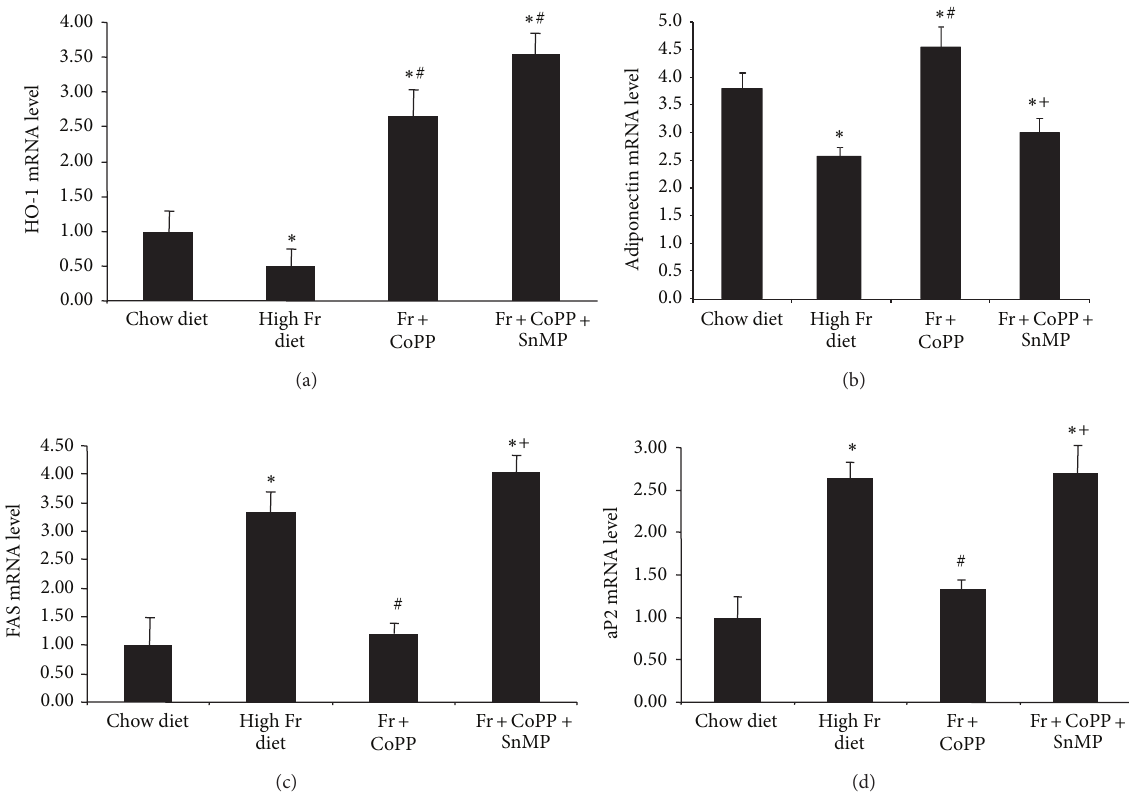
Figure 8: (a) Real-time PCR of HO-1, (b) adiponectin, (c) FAS, and (d) aP2 expression in chow diet, high fructose diet, and fructose diet treated with CoPP, in the presence or absence of SnMP. Values represent means ± SEM of five independent treatments. ∗ 𝑃 < 0.05 versus chow diet or # 𝑃 < 0.05 versus high fructose diet or + 𝑃 < 0.05 versus high fructose with